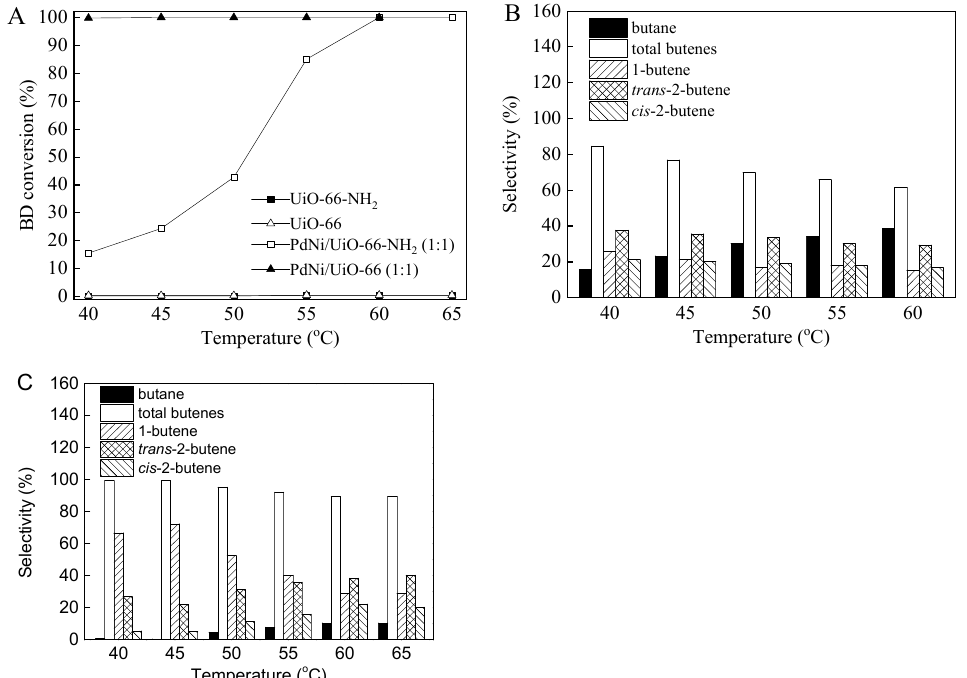
Figure 4. ( A ) BD conversions for UiO-66, UiO-66-NH 2 , PdNi/UiO-66 (1:1) and PdNi/UiO-66-NH 2 (1:1); ( B , C ) Product selectivities for PdNi/UiO-66 (1:1) ( B ) and PdNi/UiO-66-NH 2 (1:1) ( C ) as a function of temperature (reaction conditions: 5 mg of catalyst, 6.5 mL/min of H 2 flow rate, 20 mL/min of 1.0 vol.%BD/N 2 flow rate. BD conversion and product selectivities given in ( A – C ) were stable data at reaction temperature).